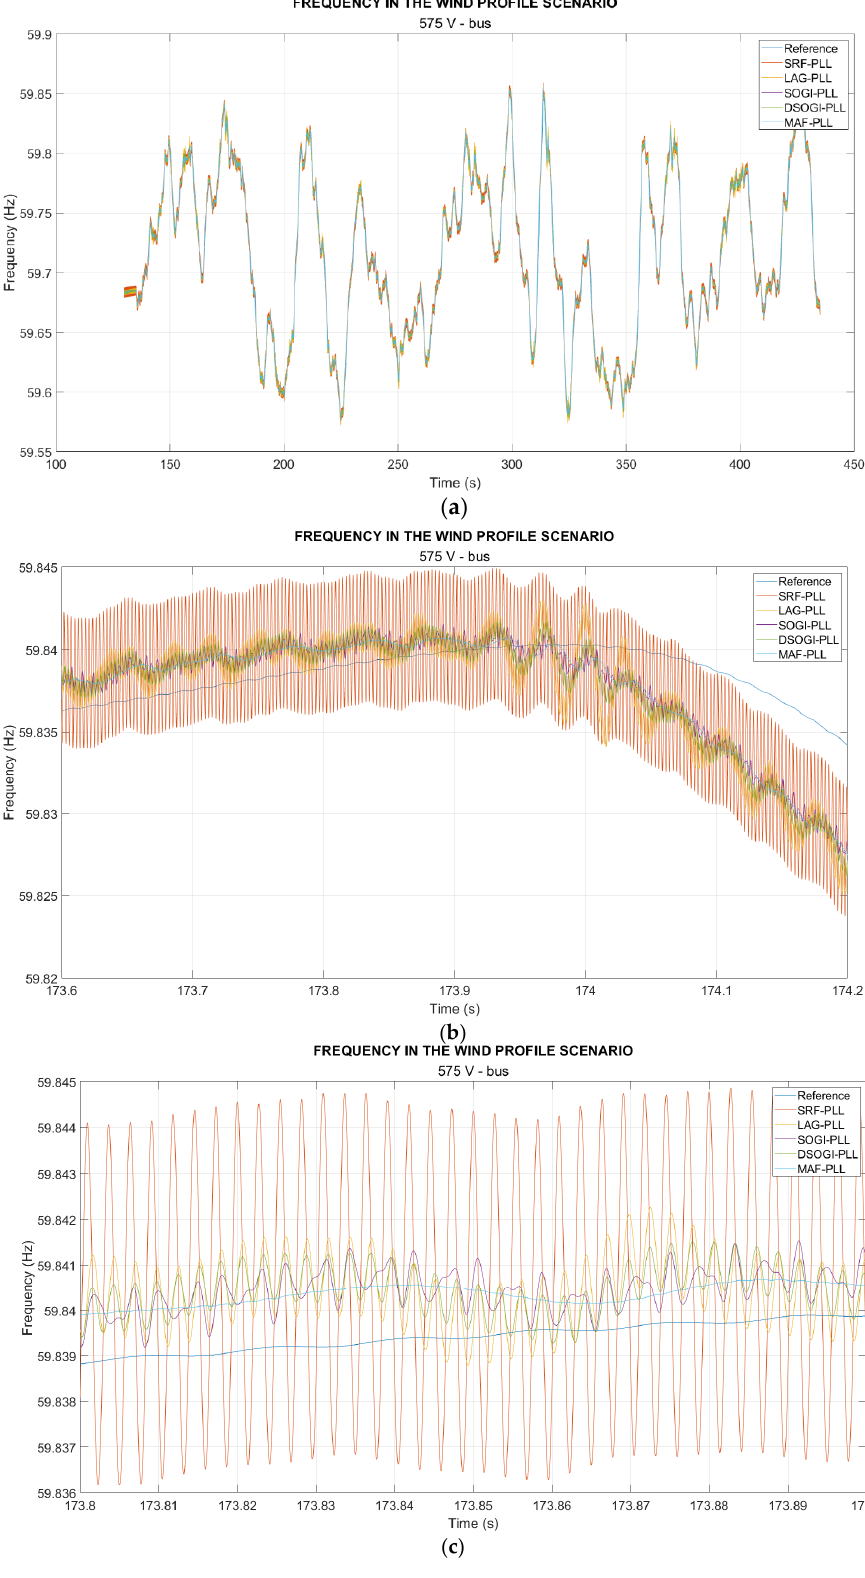
Figure 19. Frequency measurement with the PLLs located at the 575 kV WinGen bus in the variable wind speed scenario. The measurements are shown with different zoom levels: ( a ) from seconds 100 to 450, ( b ) from seconds 173.6 to 174.2, and ( c ) from seconds 173.8 to 173.9.